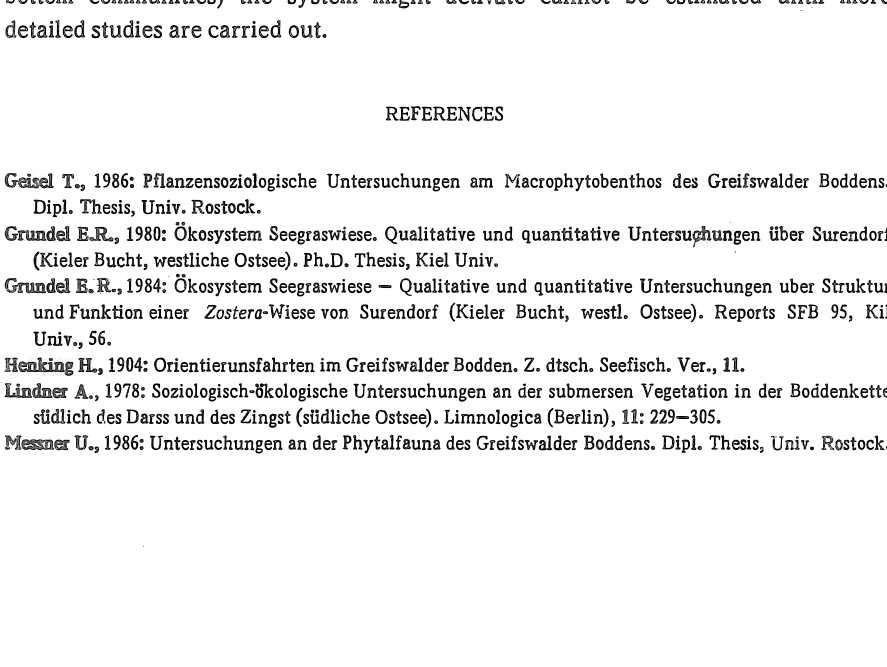
Fig. 5. Calculation of animlll biomass in tne. phytal zone 50 years age (see text) 50 years ago, is all that remains. This represents almost the total loss of an important ,several fish species and a drastic change in the material and